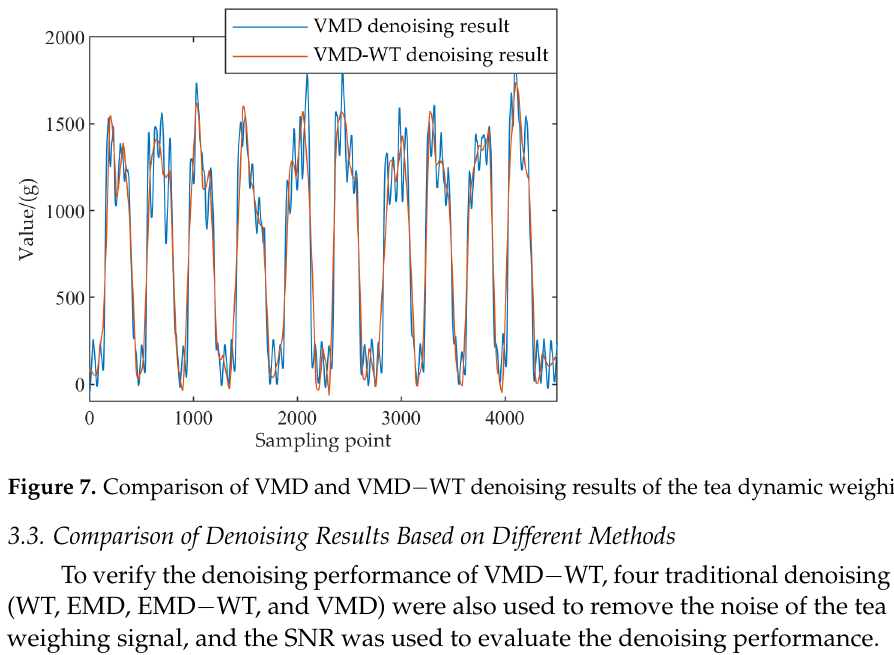
Figure 6. VMD and VMD − WT denoising results of the tea dynamic weighing signal: ( a ) VMD de- noising result and spectrum analysis; ( b ) VMD − WT denoising result and spectrum analysis.